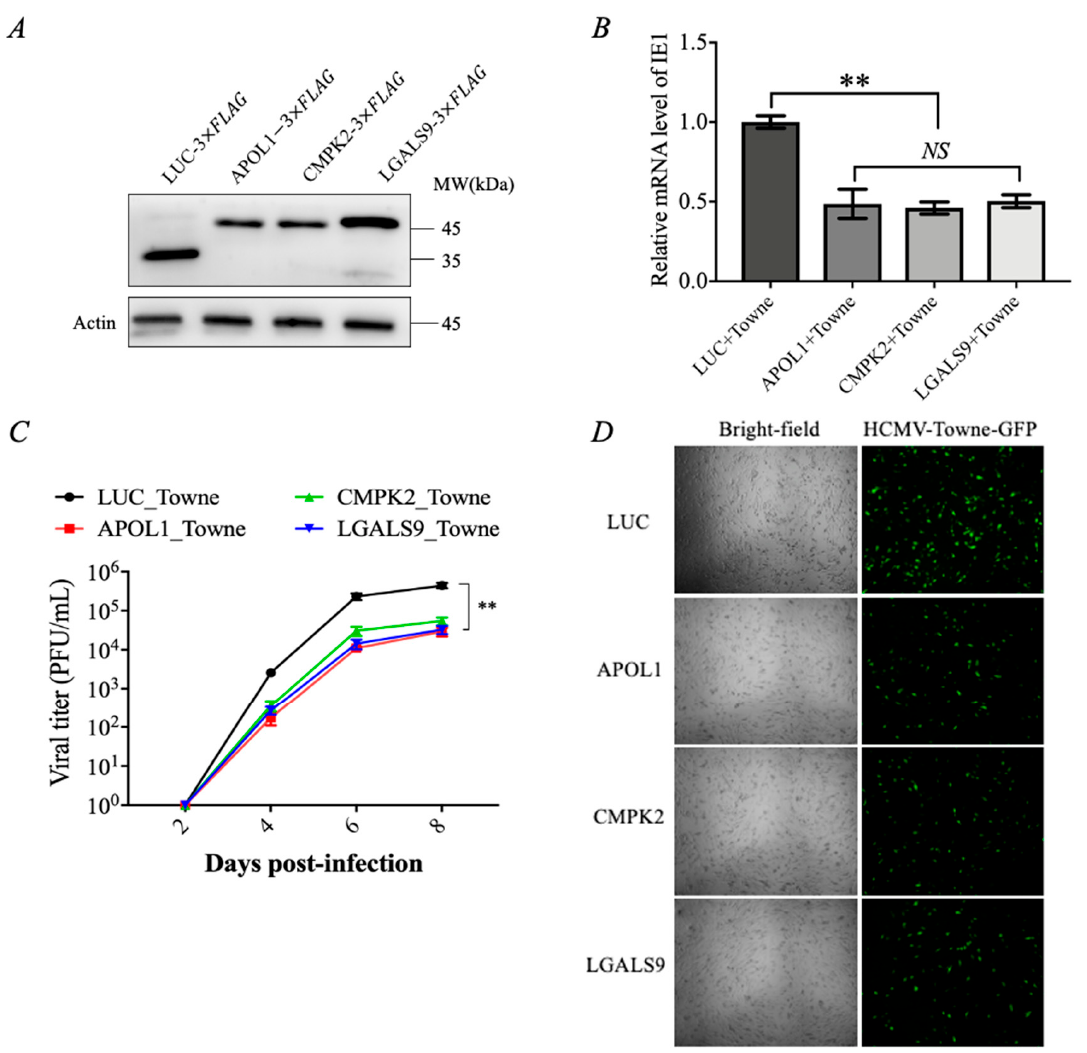
Figure 2. IFN-inducible proteins APOL1, CMPK2, and LGALS9 inhibit HCMV replication. ( A ) HFF cells were transfected with the expression constructs of LUC or APOL1, CMPK2, and LGALS9, and protein levels were analyzed by immunoblot. ( B ) Control and three protein-overexpressing (APOL1, CMPK2, and LGALS9) HFF cells were infected with HCMV-Towne at an MOI of 1. Total RNAs were prepared at 24 h, and the level of IE1 transcripts was measured by RT-qPCR. ( C ) Cell culture supernatants from cells infected with HCMV-Towne at an MOI of 1 were analyzed at different time points for progeny virus titers using infectious center assays in HFF cells. ( D ) HFF cells were infected with HCMV-Towne harboring GFP as a reporter. Cells infected at an MOI of 1 were monitored for the spread of the GFP signal. GFP images merged with phase-contrast images were collected at 7 days post-infection. Scale bar, 50 µm. Data are shown as mean ± SD. ** p < 0.01. Data are representative of three independent experiments with similar results.